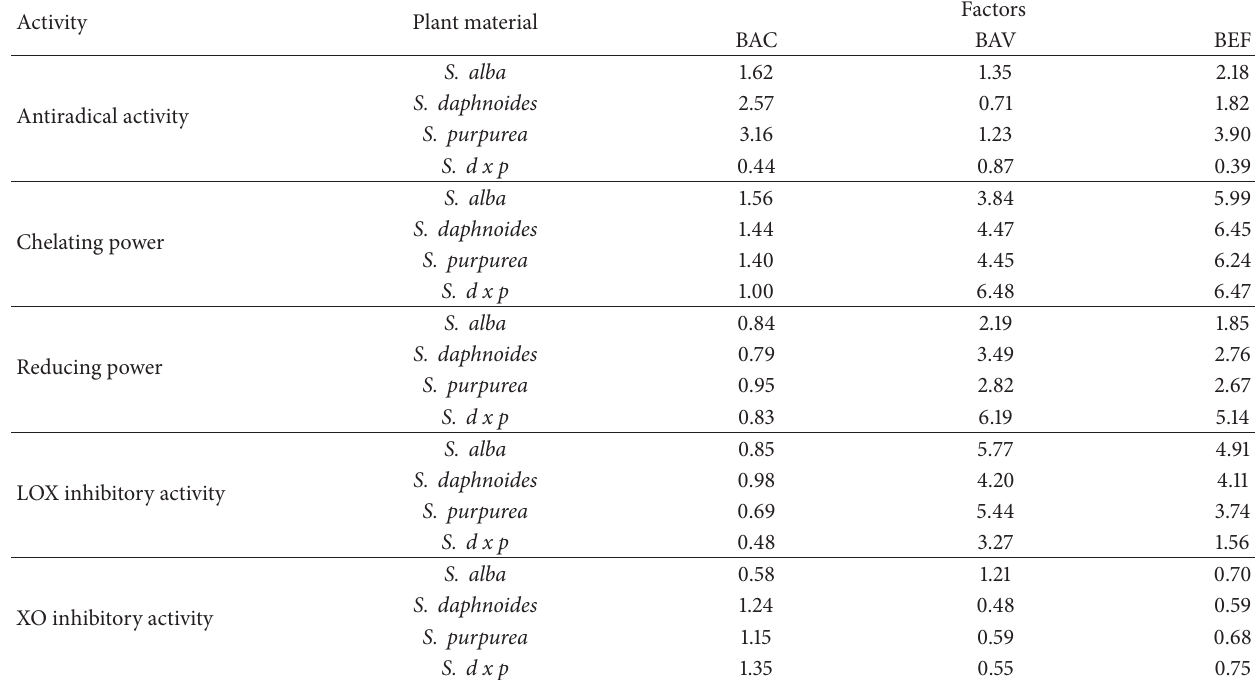
Table 2: Comparison of antioxidants bioaccessibility (BAC), bioavailability (BAV), and bioefficiency (BEF) factors. Activity